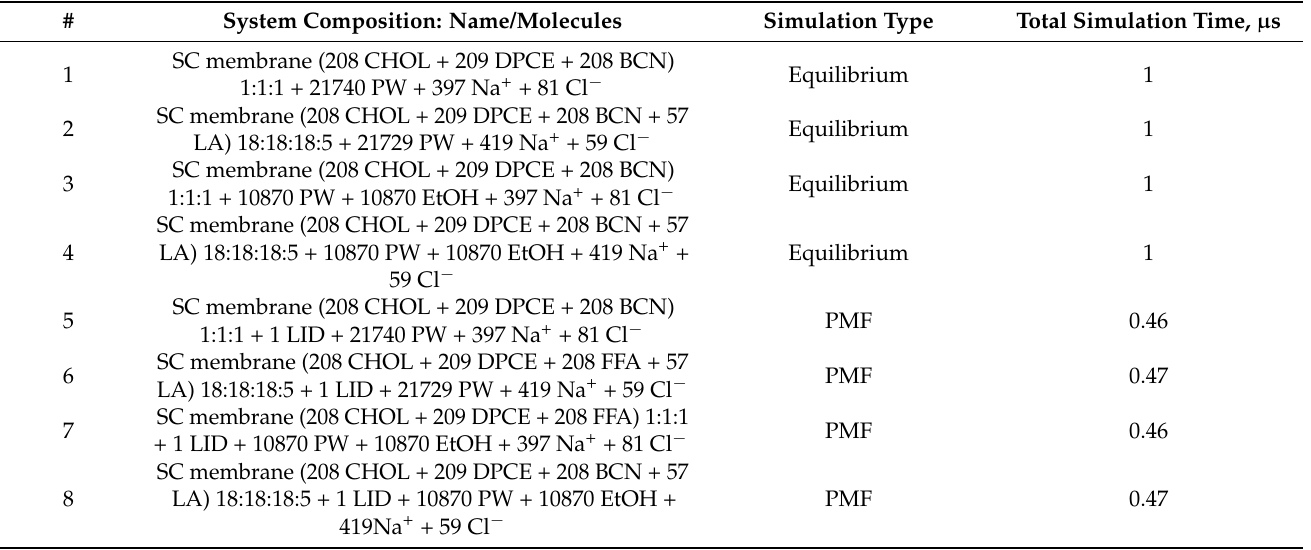
Table 1. The list of simulated systems. CHOL—cholesterol; DCPE—N-Stearoylsphingosine; BCN—behenic acid; LA— linoleic acid; EtOH—ethanol;